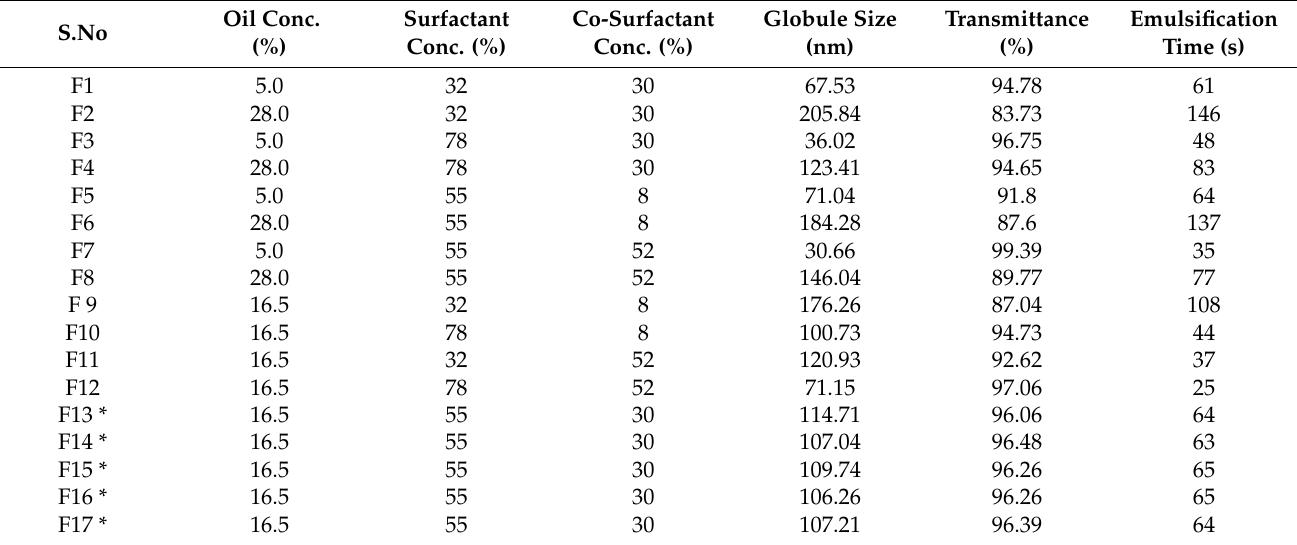
Table 2. Composition of different CEP-SNEDDs with their